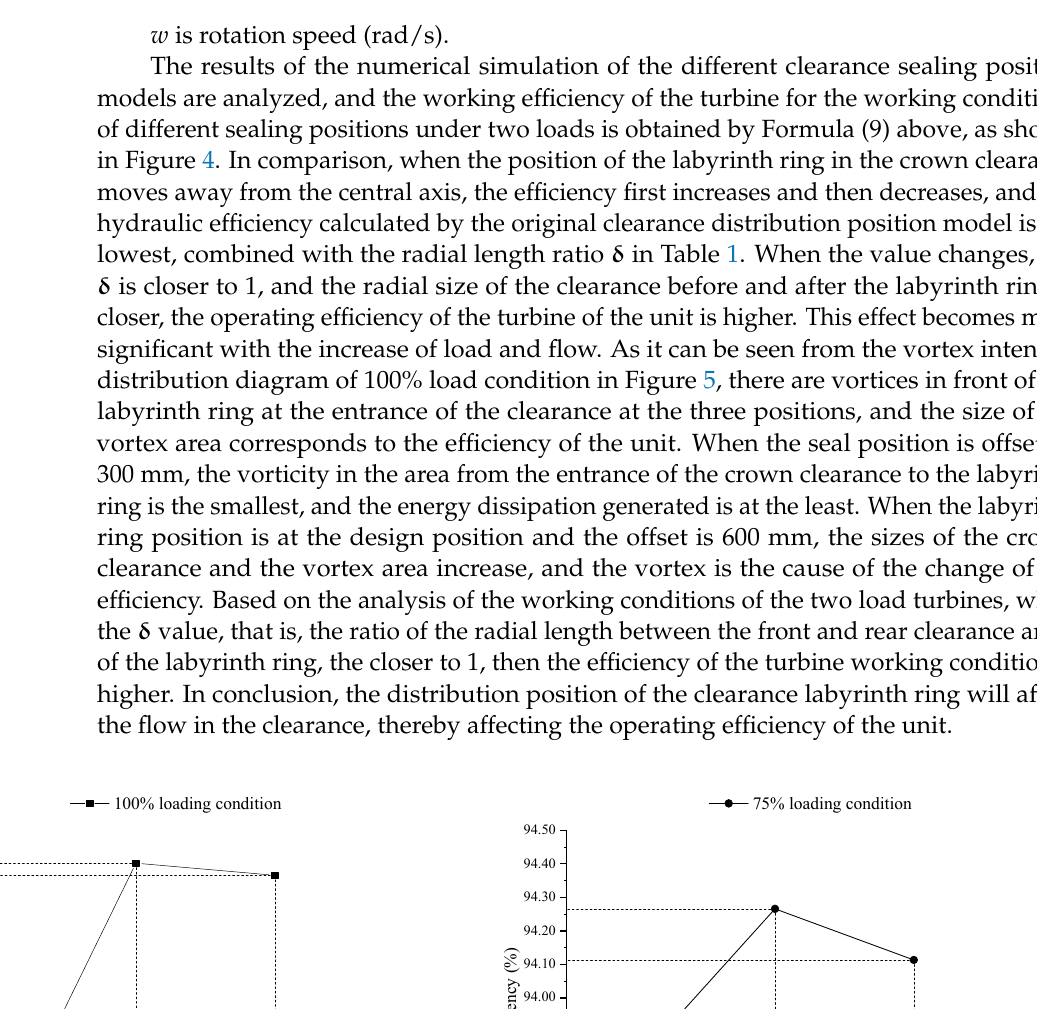
( b ) ( c ) Figure 5. Eddy viscosity distribution diagrams of upper crown clearance. ( a ) UC + 0. ( b ) UC + 300. ( c ) UC + 600. 4.2. Analysis of Force Characteristics It can be seen from Figure 6 that as the sealing position of the crown clearance changes away from the central axis, the resultant hydraulic thrust increases, and the trend of the change is consistent under different load conditions. From the specific analysis of the component force, the change of the resultant force of the hydraulic thrust is mainly affected by the change of the component force F 1 . The change of the component force F 1 by the change of the position of the crown clearance seal is shown in Figure 7. When the position is far from the central axis, the vertical downward hydraulic thrust generated